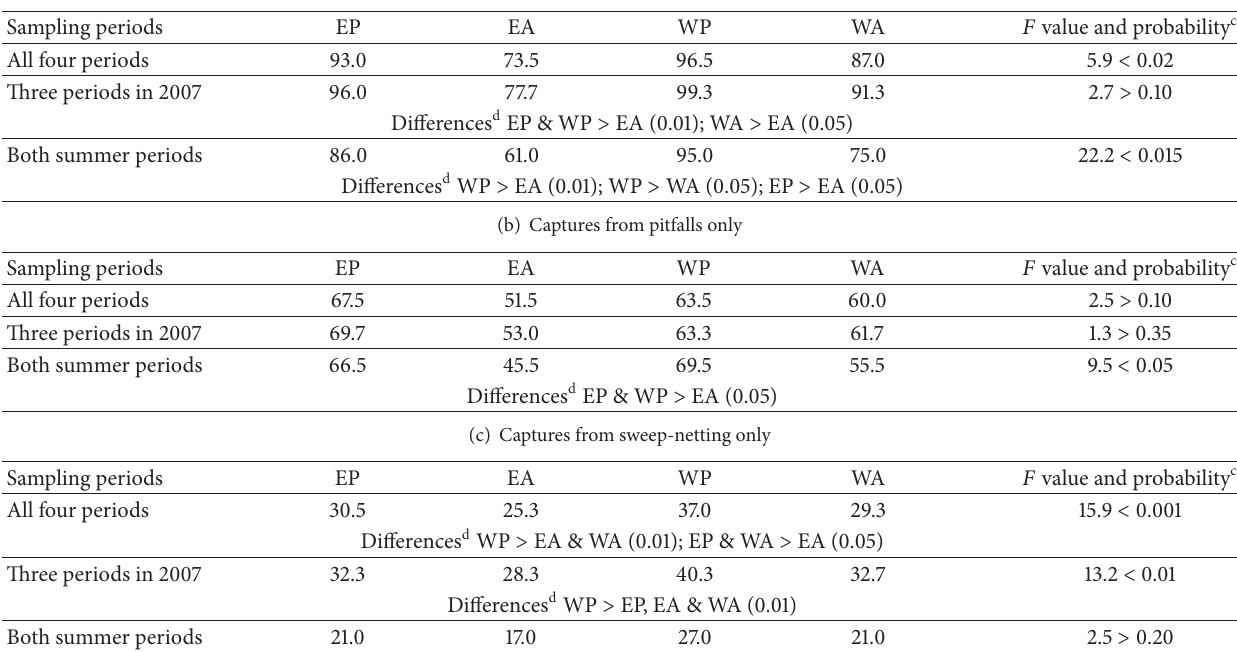
Table 2: Average morphospecies richness a for each sampling area for three combinations of sampling periods, 𝐹 values, and listing of averages that were significantly different. (a) Combined captures of both methods b . (b) Captures from pitfalls only. (c) Captures from sweep-netting only.